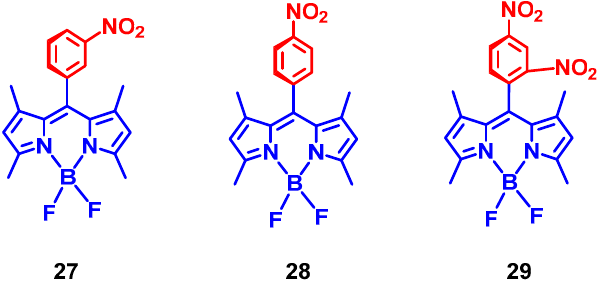
Figure 9. Dyads with Bodipy as electron donor. No SOCT-ISC was observed.